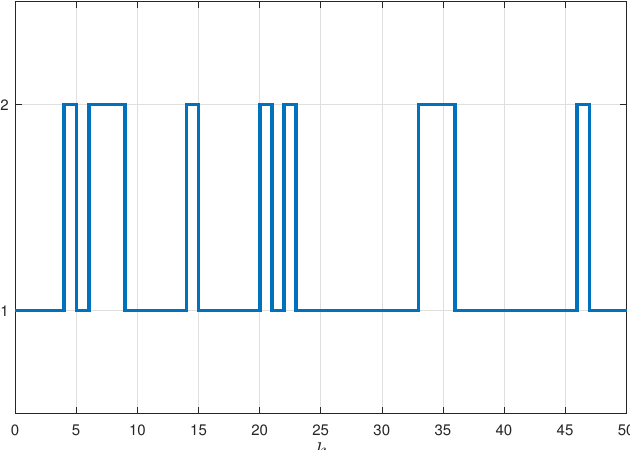
Figure 7. Mode values of Markov chains of an intermittent fault.